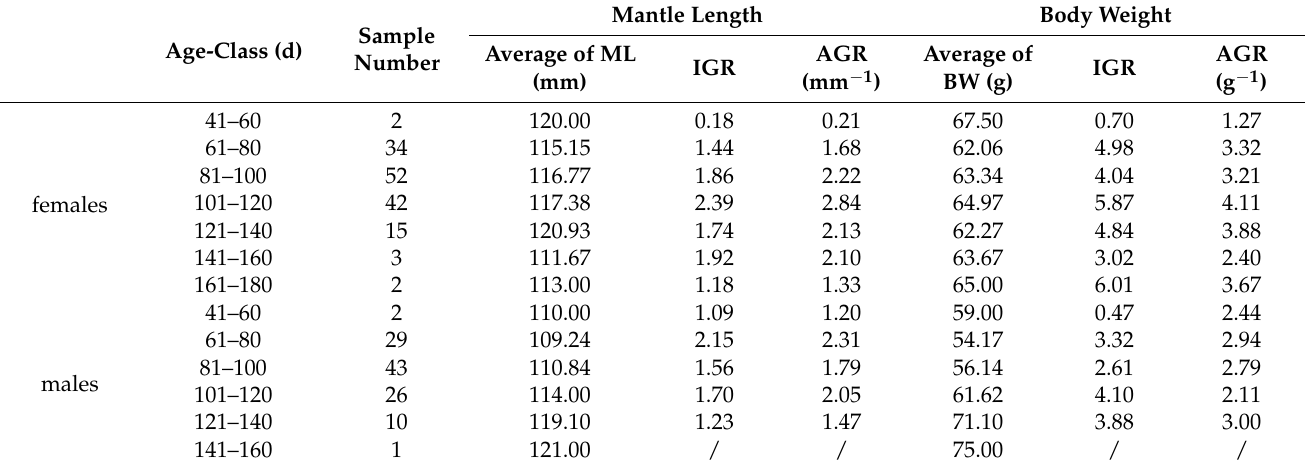
The maximum AGR (Figure 8a) and IGR (Figure 8b) values for ML were 2.84 mm/d and 2.389%/d for the females, within 101–120 days, and the maximum AGR (Figure 8a)